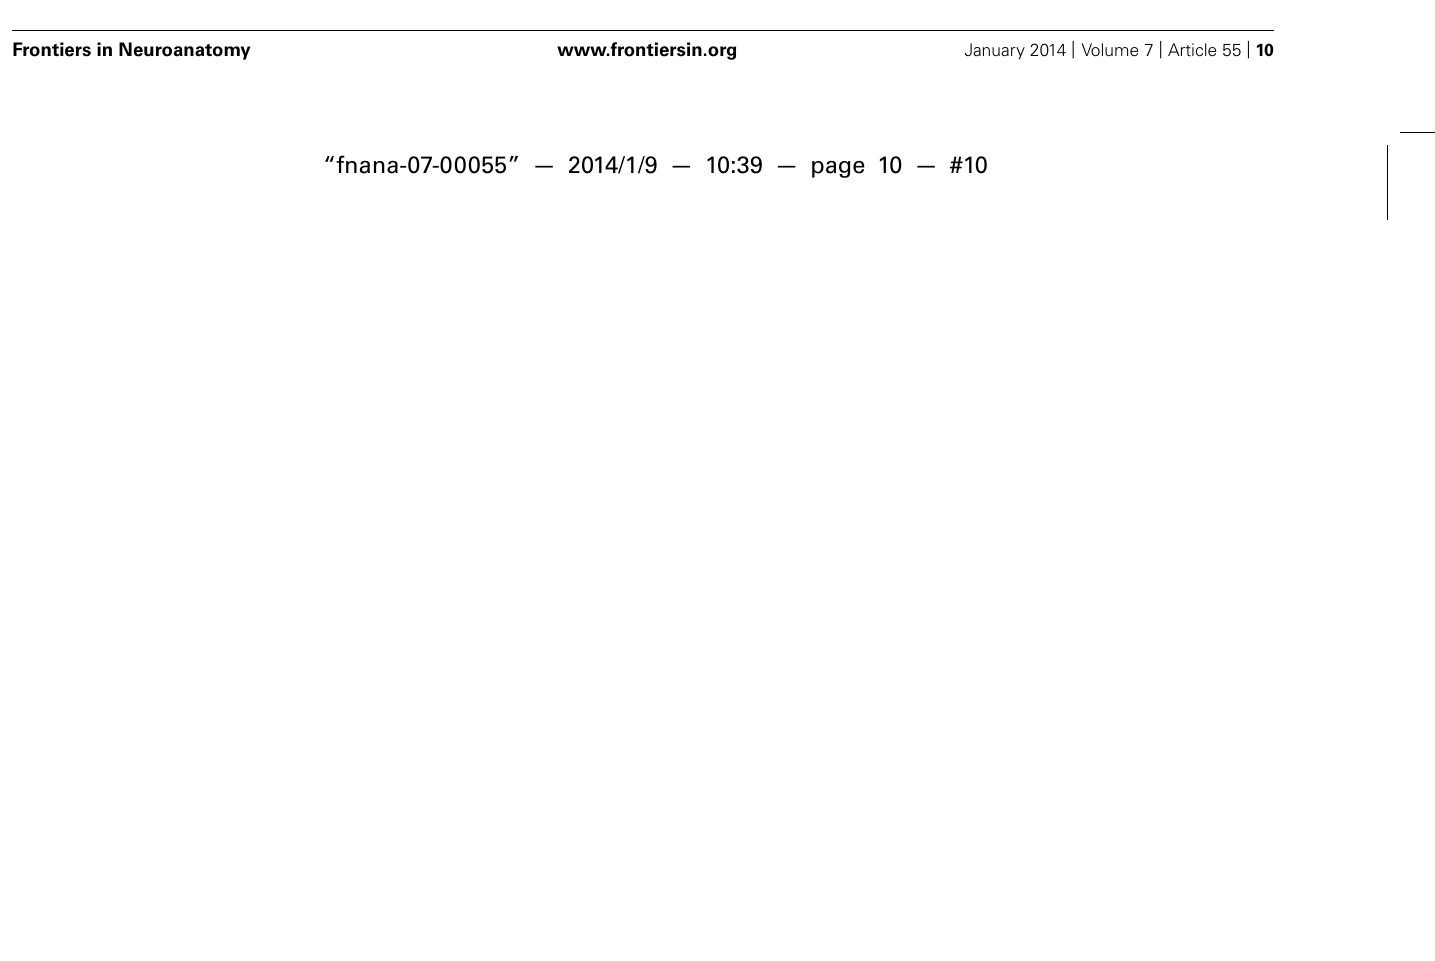
were observed when the medulla and pons were